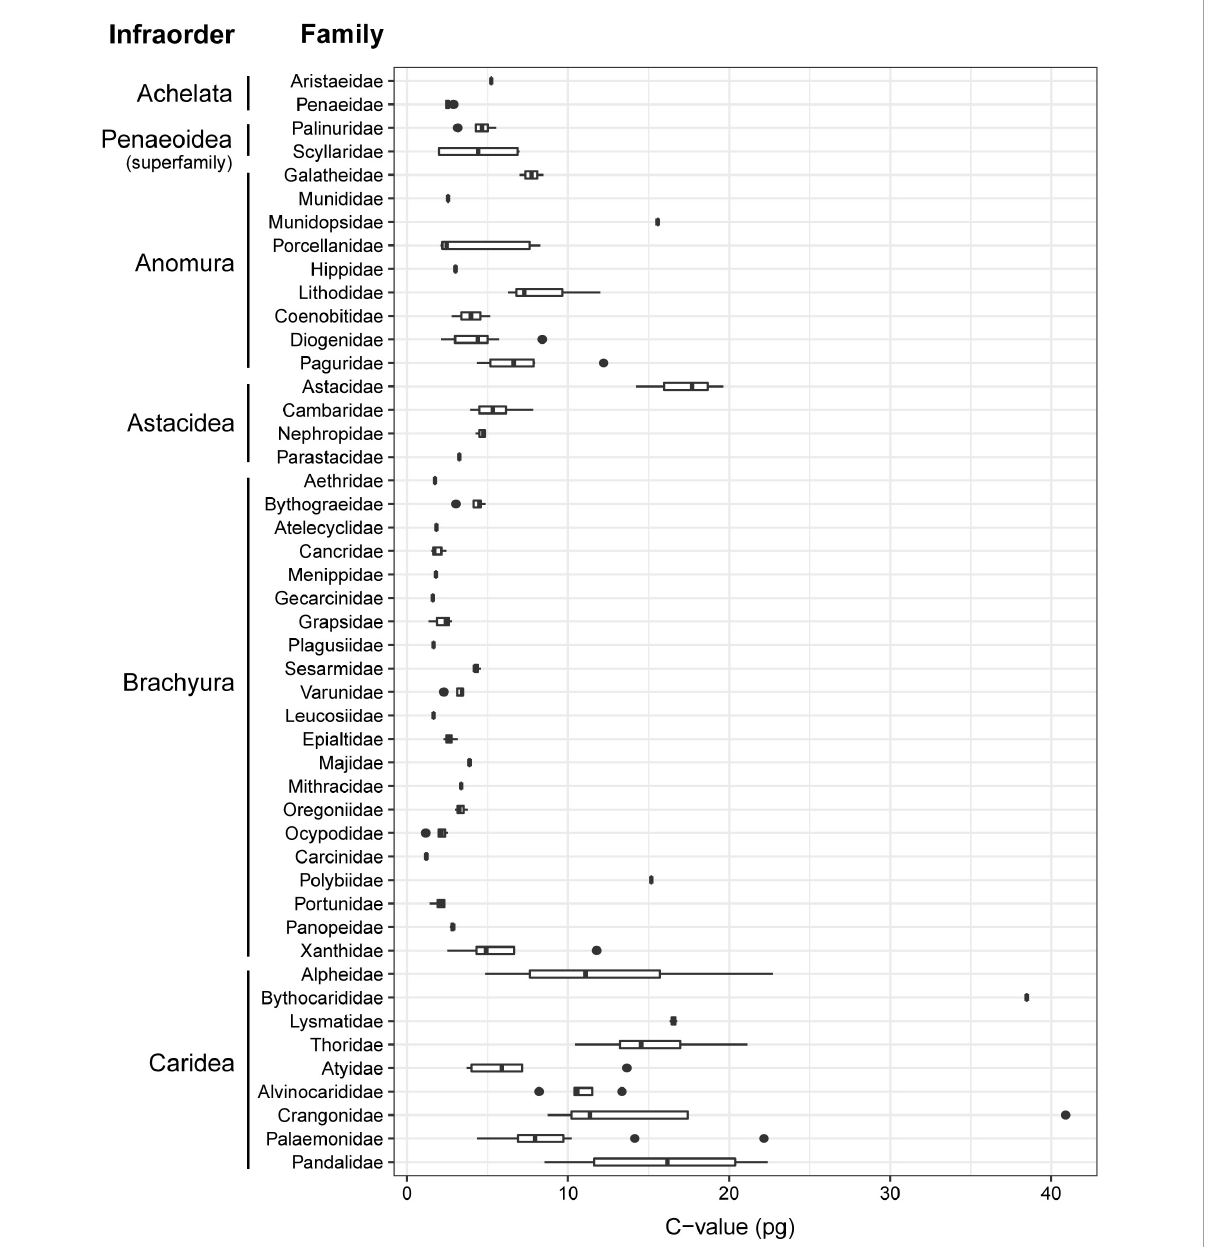
FIGURE2 Range of genome size (pg, uncorrected values) for the decapod families included in this study. Where present, the vertical line within the box indicates the median and the horizontal whiskers the 95% confidence intervals.